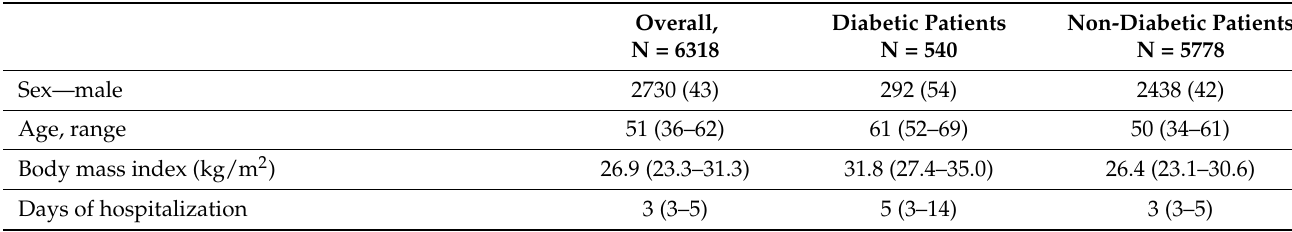
Table 1. Clinical characteristics in elective orthopedic foot and ankle surgery.